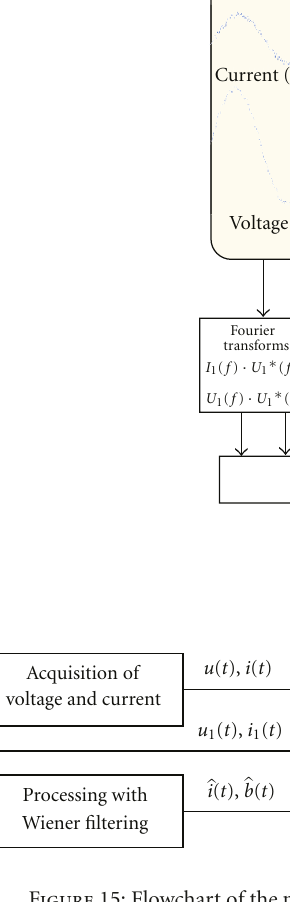
Figure 15: Flowchart of the proposed method.